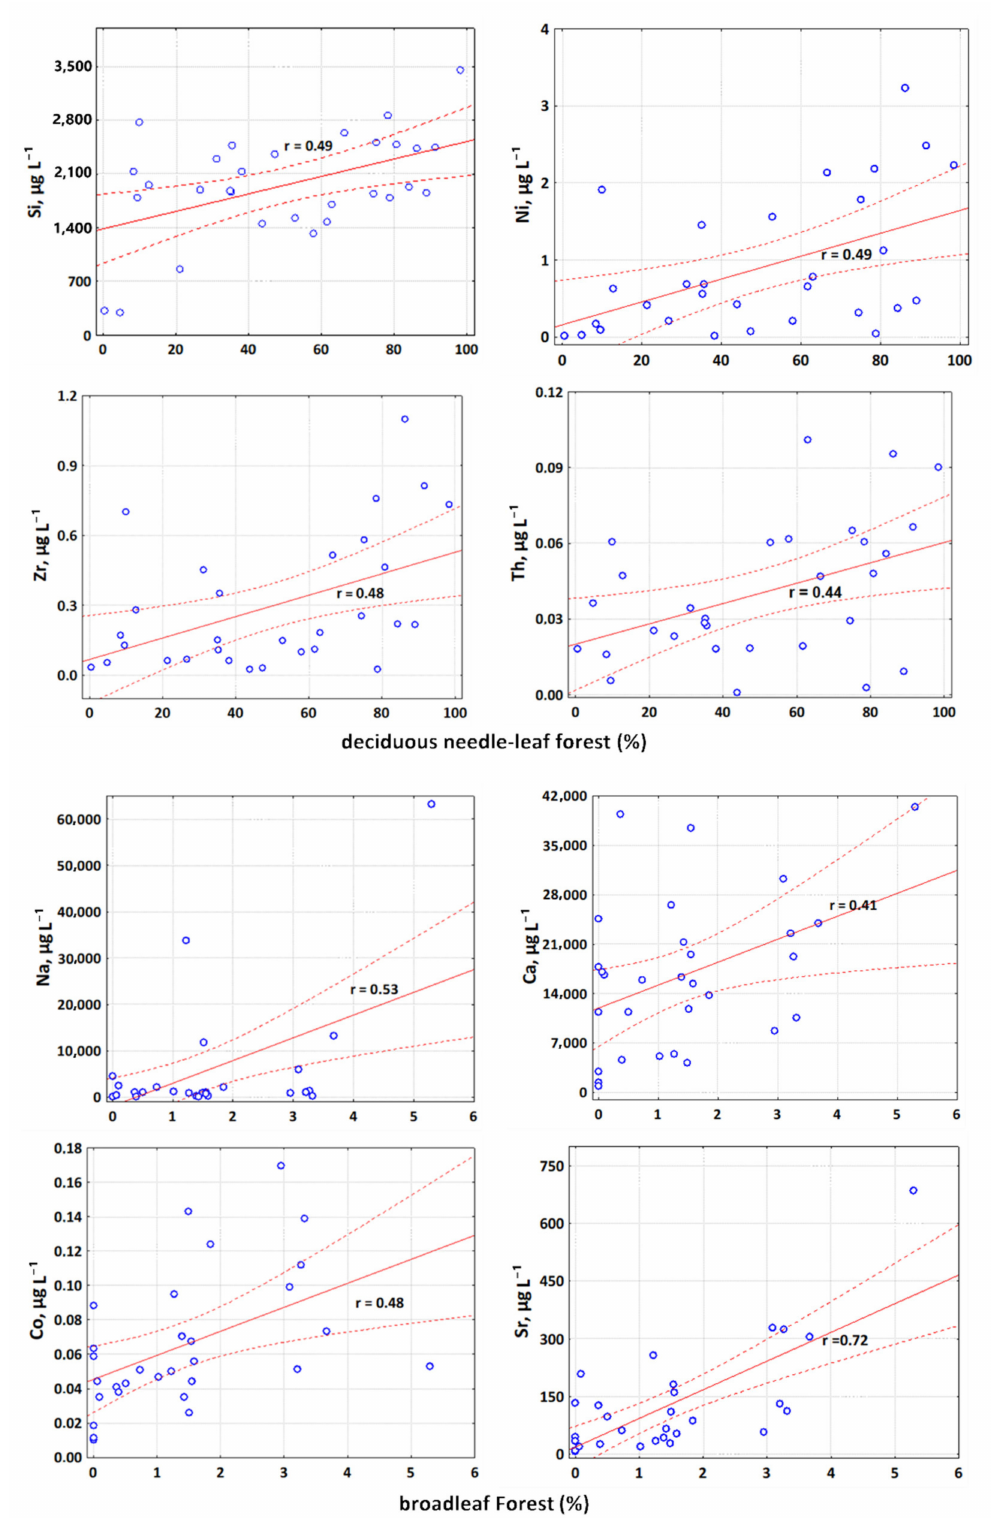
Figure 5. Significant ( p < 0.05) positive control of landscape parameters—percentage of deciduous needle-leaf forest (Si, Ni, Zr, Th) and broadleaf forest (Na, Ca, Co, Sr) on element concentration in the Lena River